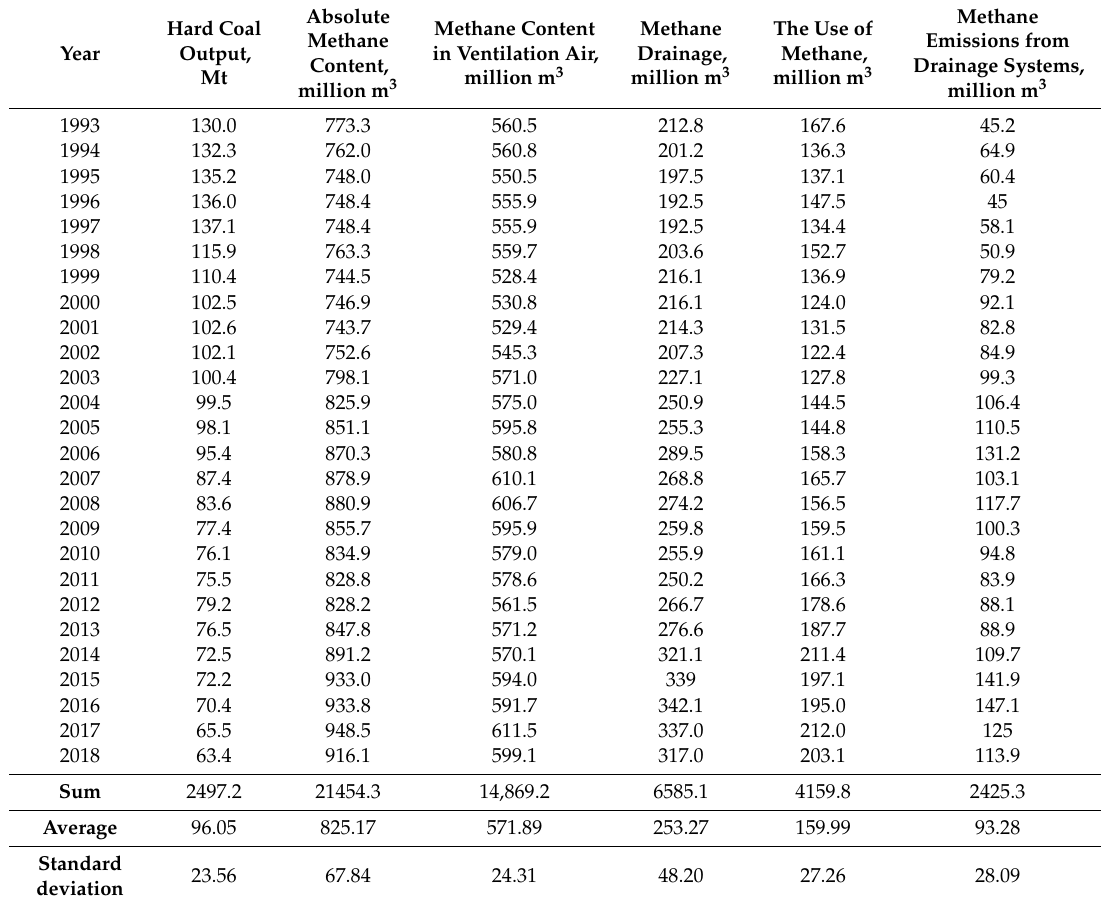
Table 1. Methane extraction and emission from Polish hard coal mines between 1993–2018. Hard Coal Year Output,